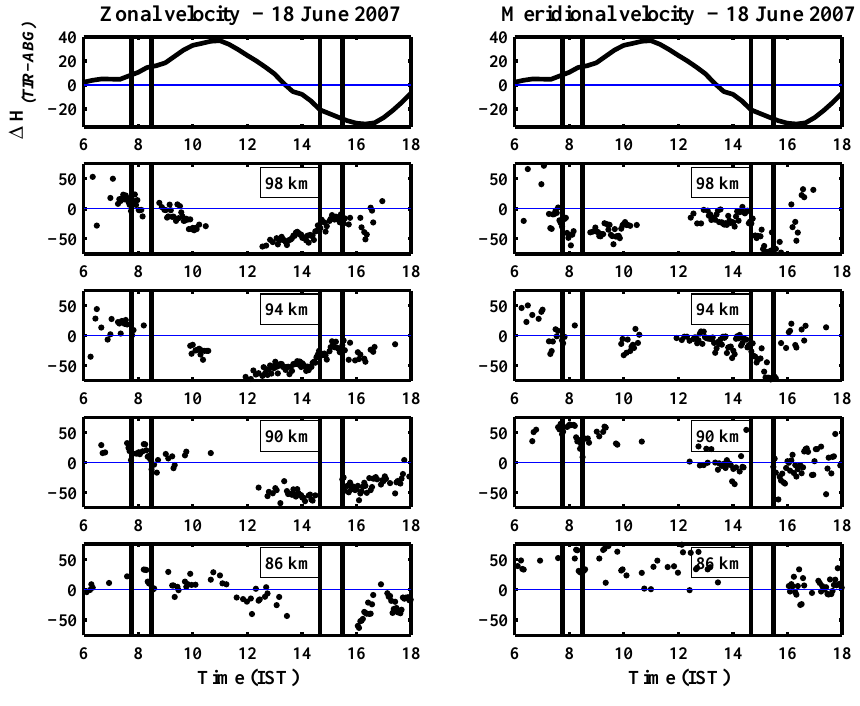
Fig. 3d. Same as Fig. 2d but for 18 June